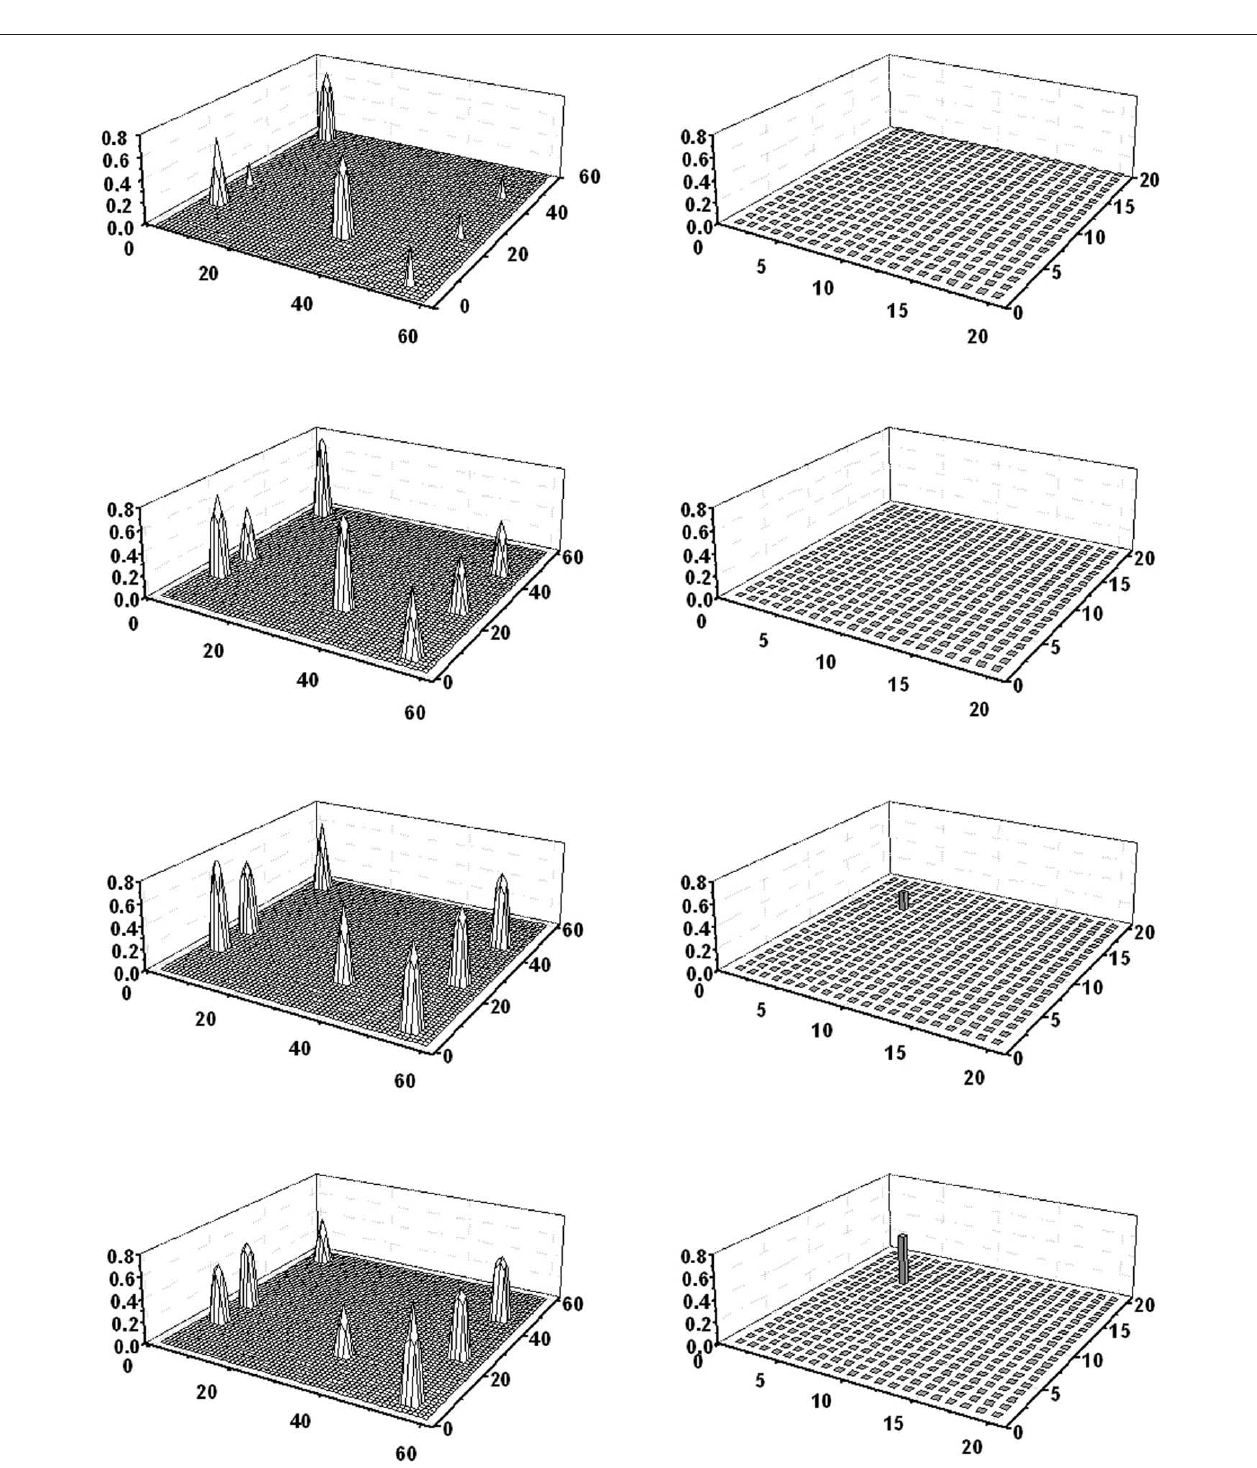
three features progressively evoke the four remaining features of dog in the semantic network; when the overall conceptual representation is reconstructed, the word coding for “dog” is activated in the lexical area (fourth line). It is worth noting that the distinctive properties of cat are not evoked. Neither the word coding for “cat,” nor the word naming for the category (“pet”) appear in the lexical